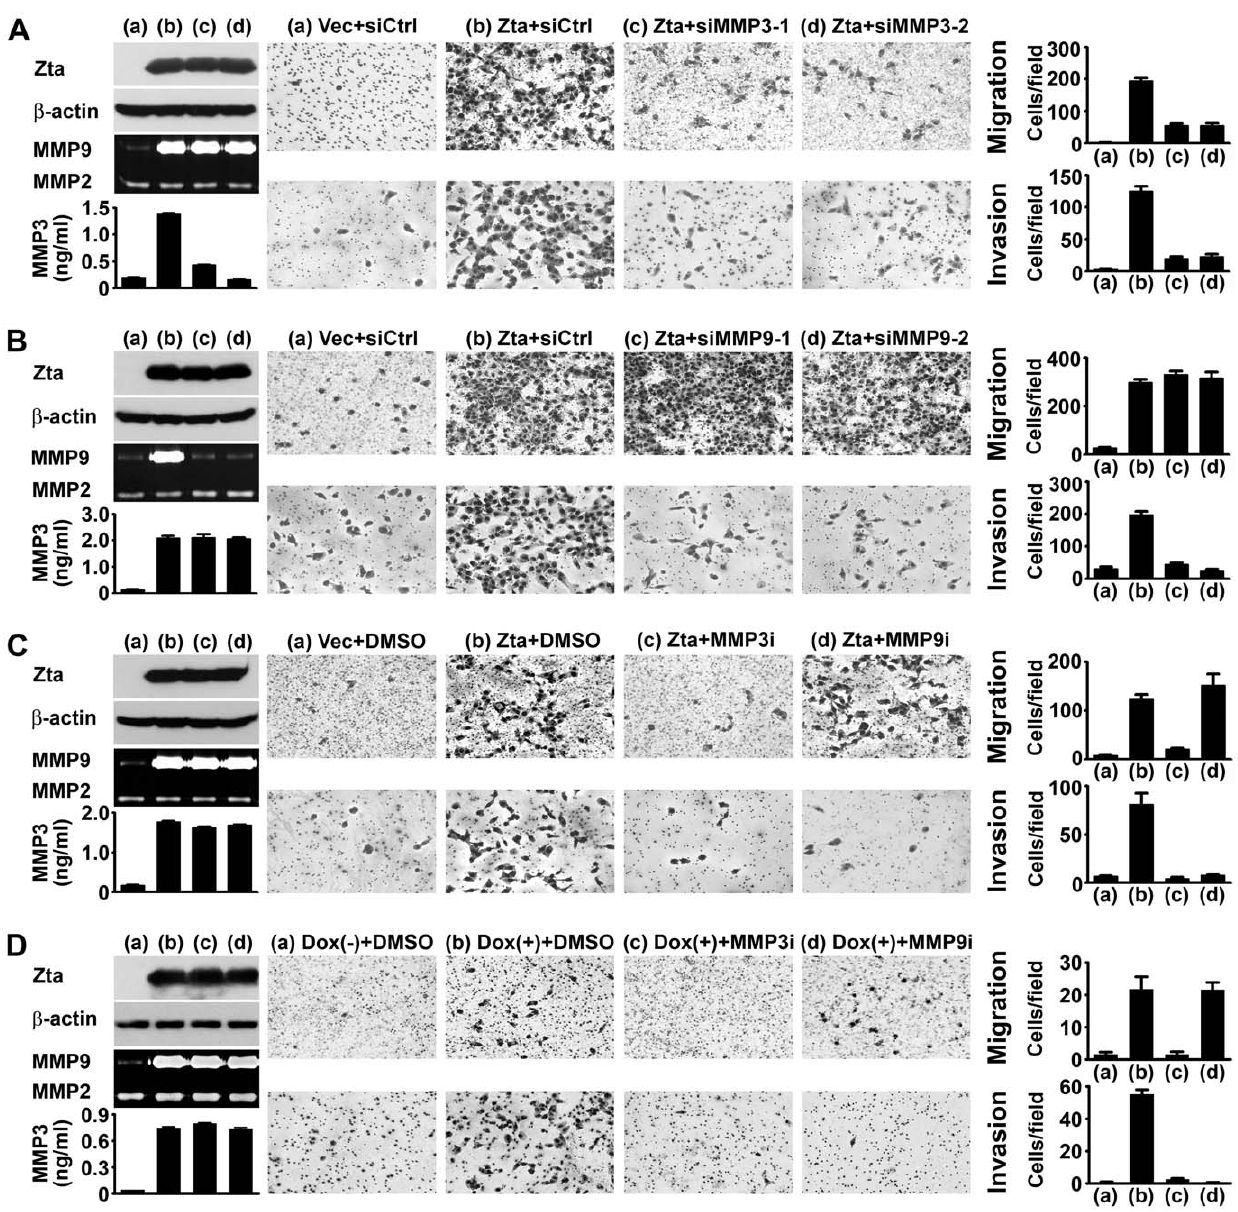
Figure 6. Zta-induced cell migration requires MMP3 while Zta-induced cell invasion requires both MMP3 and MMP9. ( A ) HONE-1 cells were cotransfected with a control siRNA (siCtrl) or MMP3-targeted siRNAs (siMMP3-1 and siMMP3-2) in combination with a vector plasmid (Vec) or a Zta-expressing plasmid (Zta). ( B ) HONE-1 cells were cotransfected with a control siRNA or MMP9-targeted siRNAs (siMMP9-1 and siMMP9-2) in combination with a vector plasmid or a Zta-expressing plasmid. ( C ) HONE-1 cells transfected with a vector plasmid or a Zta-expressing plasmid were treated with the solvent control DMSO, an MMP3 inhibitor (MMP3i), or an MMP9 inhibitor (MMP9i). ( D ) HONE-tetonZ cells with ( + ) or without ( 2 ) induction by doxycycline (Dox) were treated with the solvent control DMSO, an MMP3 inhibitor (MMP3i), or an MMP9 inhibitor (MMP9i). Protein expression of Zta and b -actin was examined by an immunoblotting assay. Production of MMP9 and MMP2 in the cell culture supernatants was detected by using a gelatin zymography assay. Concentrations of MMP3 in the cell culture supernatants were quantified by using ELISA. Cell migration was examined by using a transwell migration assay, and cell invasion in ECM was examined by using a Matrigel invasion assay. Shown are the microscopic observations of migrating or invading cells and the average numbers of the cells per